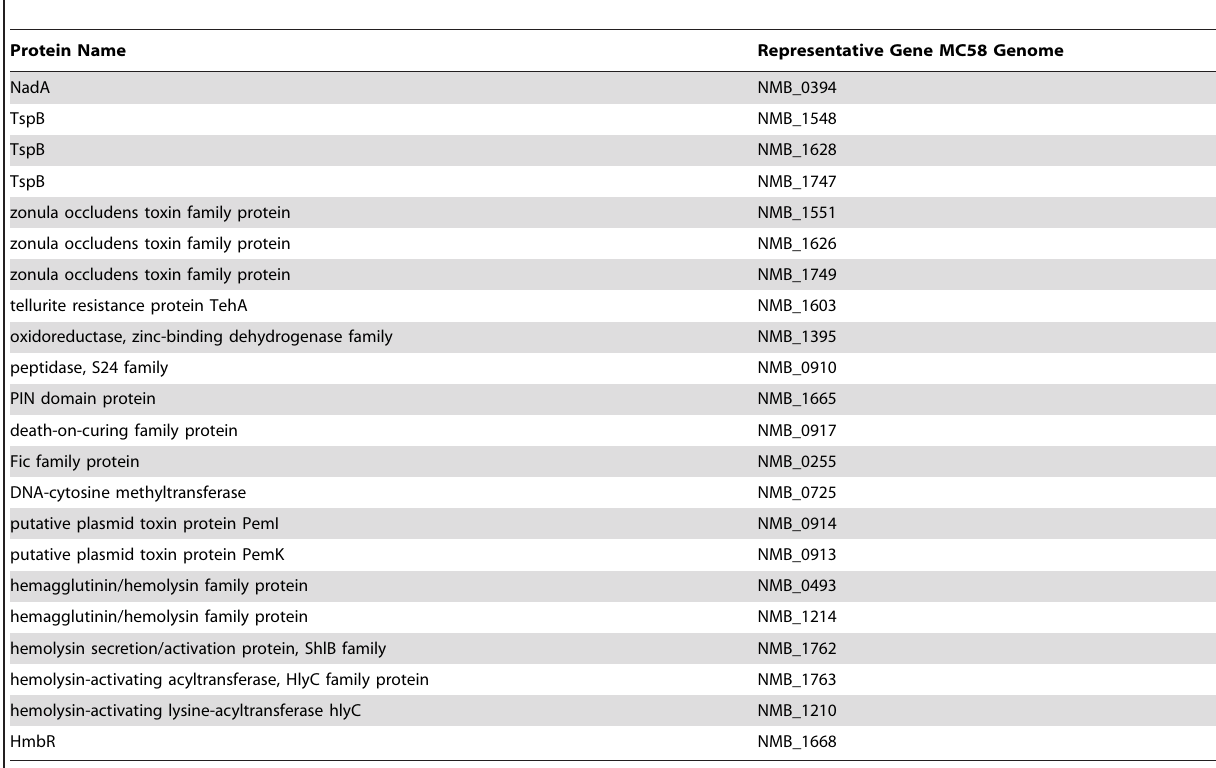
Table 2. Genes found in a majority of sequenced genomes but absent from NM220 and